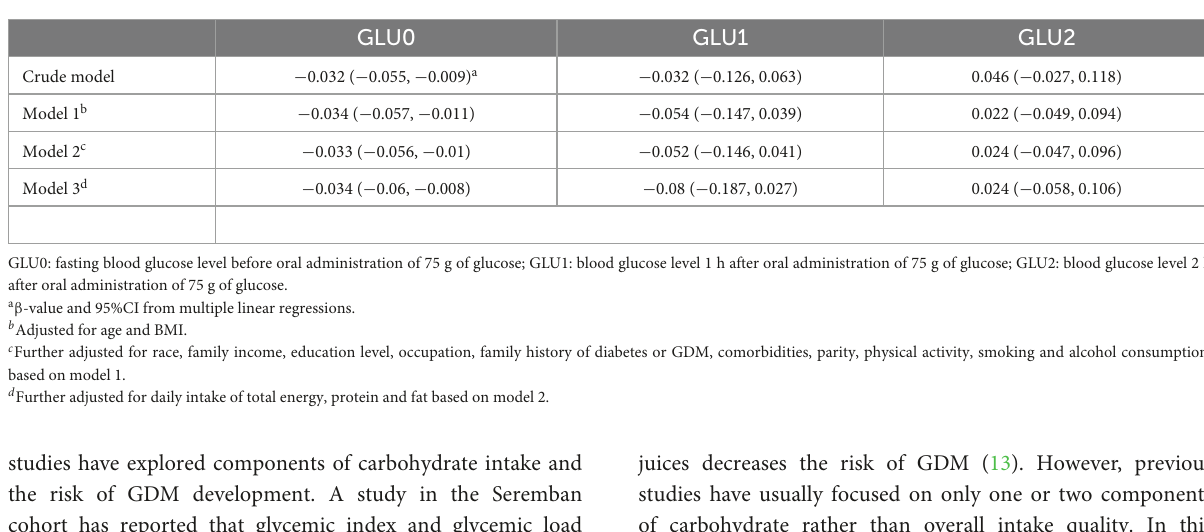
TABLE 5 Associations between CQI and blood glucose levels at different time points during